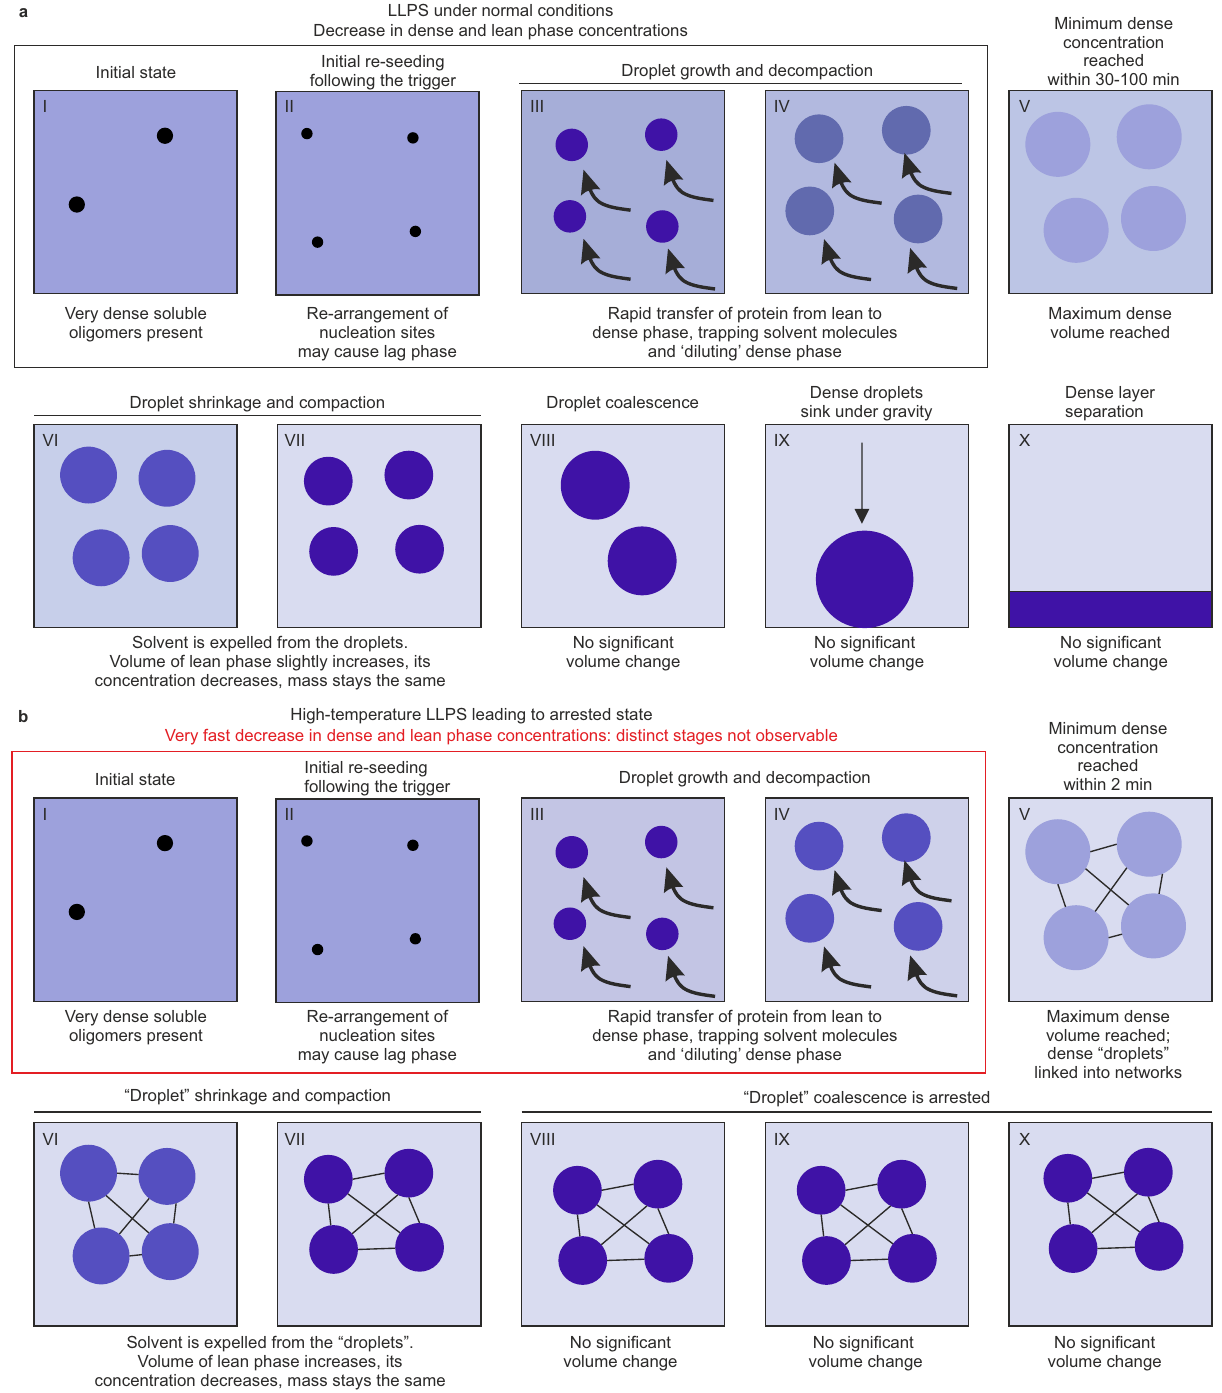
Fig. 7 Proposed model for BSA LLPS stages. Progression of LLPS following temperature jumps to 40 °C and 45 °C ( a ), and 50 °C leading to an arrested state ( b ). Intensity of the colour re fl ects the concentration of the evolving dense and lean species. The shaded areas re fl ect the total volume of dense and lean phases. The term “ droplet ” is de fi ned here in a wide sense, as a portion of the sample dense phase characterised by the uniform concentration and density, with the total phase volume known for the whole sample. The size of the individual droplets is not de fi ned here, but for convenience can be assumed to be uniform. For arrested states such “ droplets ” can be represented as linked networks, preventing their coalescence and settling, whereas for non-arrested states these would correspond to dense phase droplets as observed in